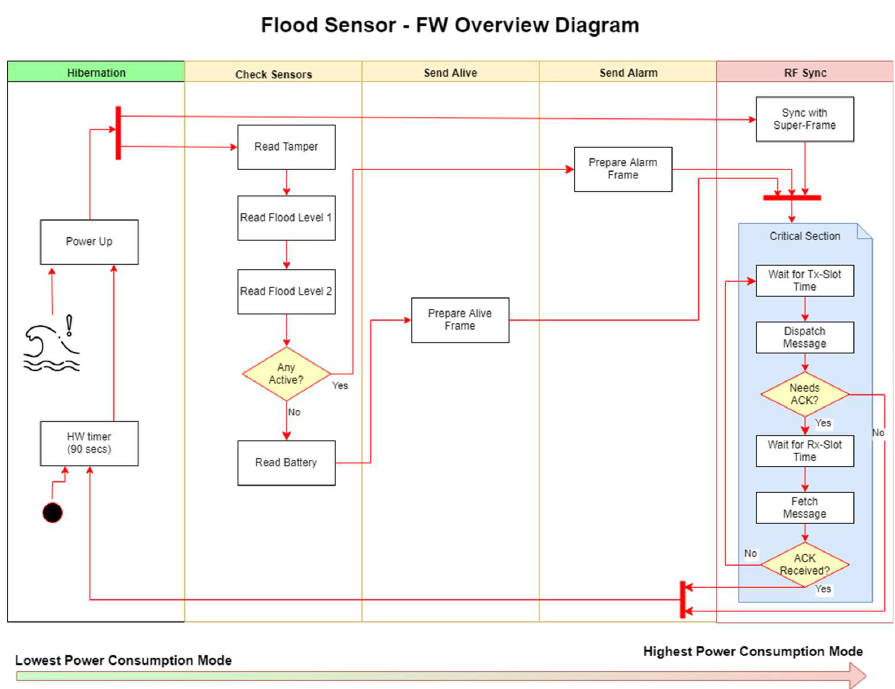
Figure 9. Firmware overview diagram for the flood sensor.